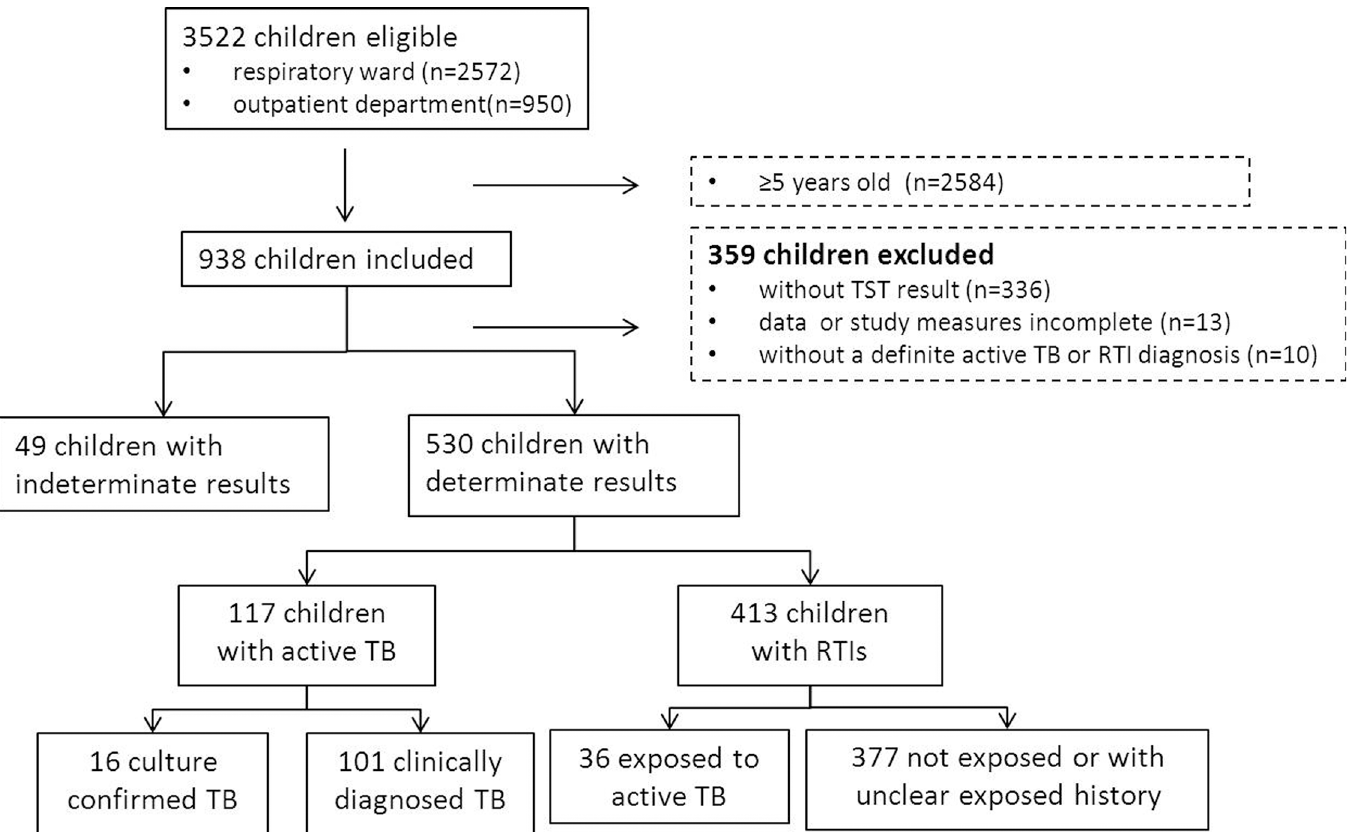
Fig 1. Flow diagram summarizing patient recruitment, exclusion criteria, and the patient